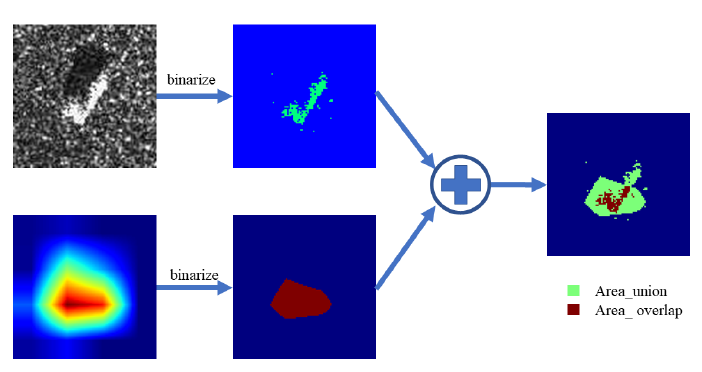
Figure 3. Explanation of Area_overlap and Area_union in IoU.